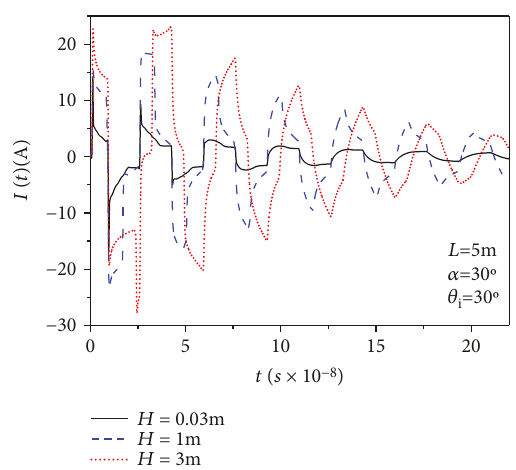
Figure 13: The comparison of induced current between isotropic and anisotropic